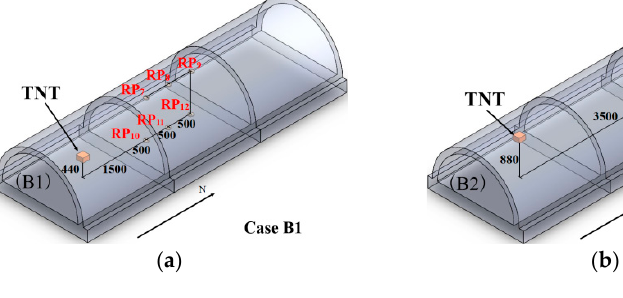
Figure 3. Layout of reflected overpressure sensors (unit: mm): ( a ) Case B1; ( b ) Case B2; ( c ) Case B3.